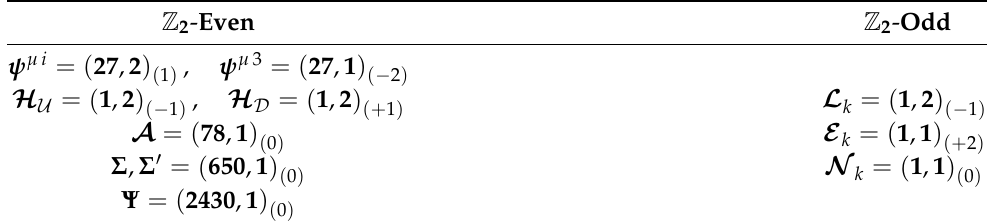
Table 1. Fundamental superfield content of the anomaly-free 4-dimensional SUSY E 6 × SU ( 2 ) F × U ( 1 ) F GUT. Here, i = 1,2 and k =